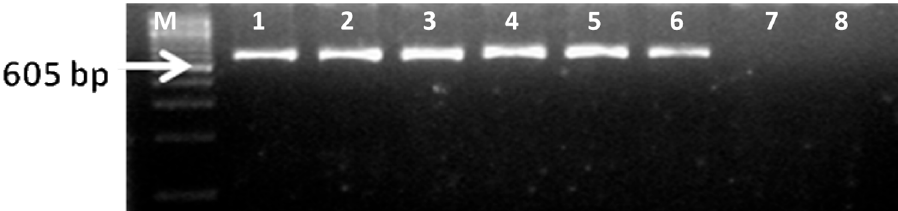
Figure 2. Polymerase chain reaction (PCR) based confirmation of RABV from suspected brain samples with JW12 and JW6deg primers (605 bp) (from different states). Lane M: 100 bp DNA ladder; Lane 1: